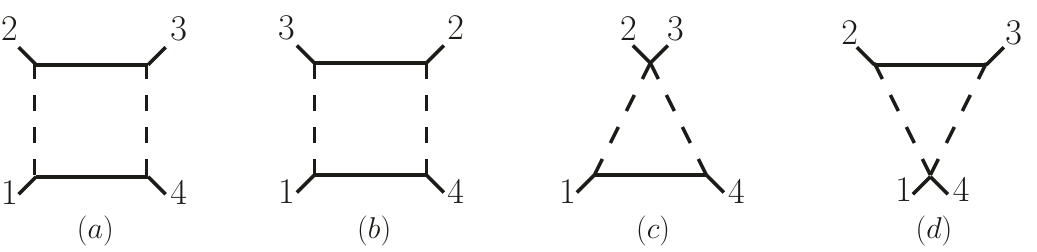
Figure 3 . The one-loop scalar box integrals I (cid:3) (a) and I ./ (b) and the corresponding triangle integrals I 4 (c) and I 5 (d). The bottom (top) solid line corresponds to a massive propagator of mass m 1 ( m 2 ). The dashed lines denote massless